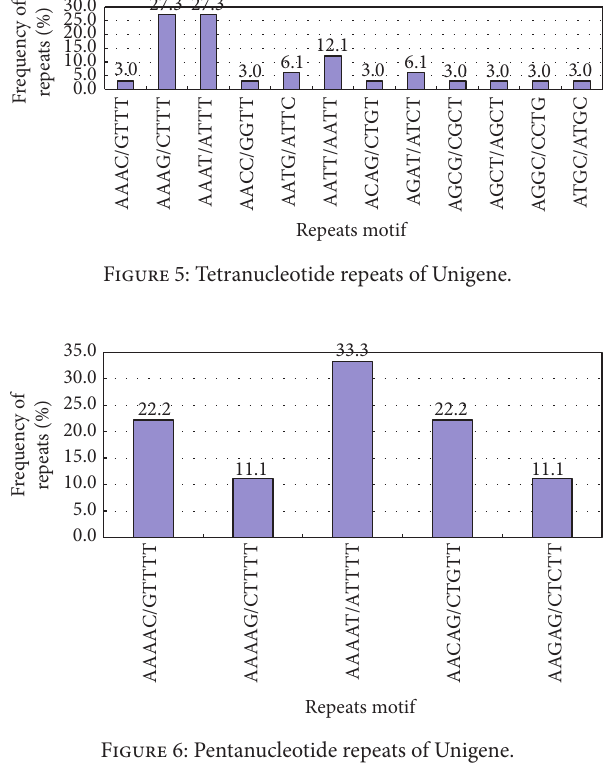
Table 4: SSR locus length. SSR locus length (bp) Number of SSRs Accounting for (100%)